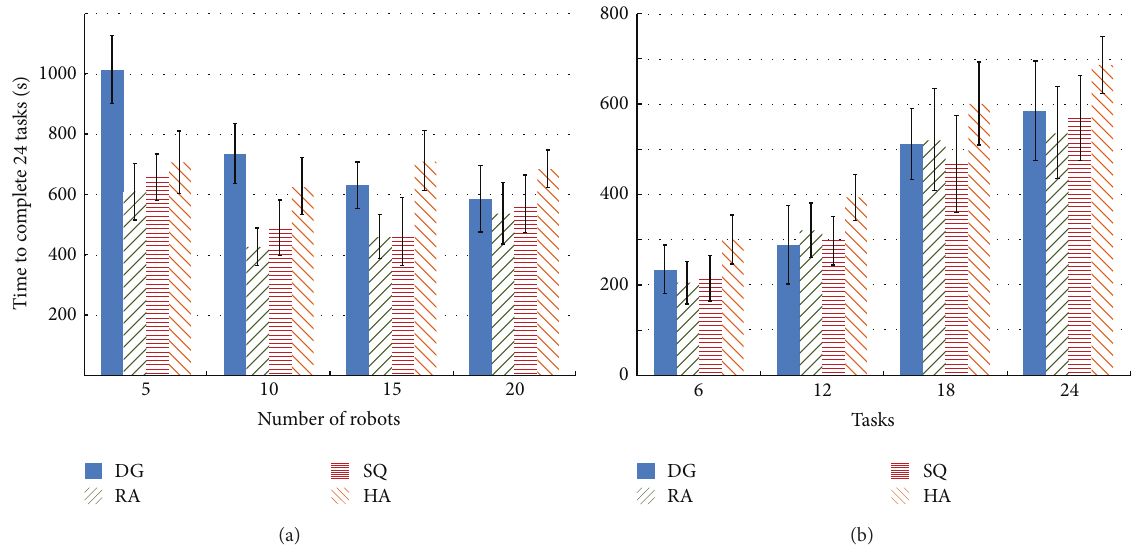
Figure 9: Completion times with fixed task load of 24 tasks for 5 , 10 , 15 , and 20 robots (a) and with fixed number of 20 robots for 6 , 12 , 18 , and 24 tasks (b) for the compared MRTA approaches.